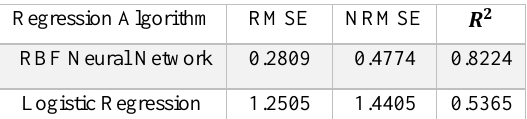
Table 2: RMSE, NRMSE, 𝑅 2 values for different regression